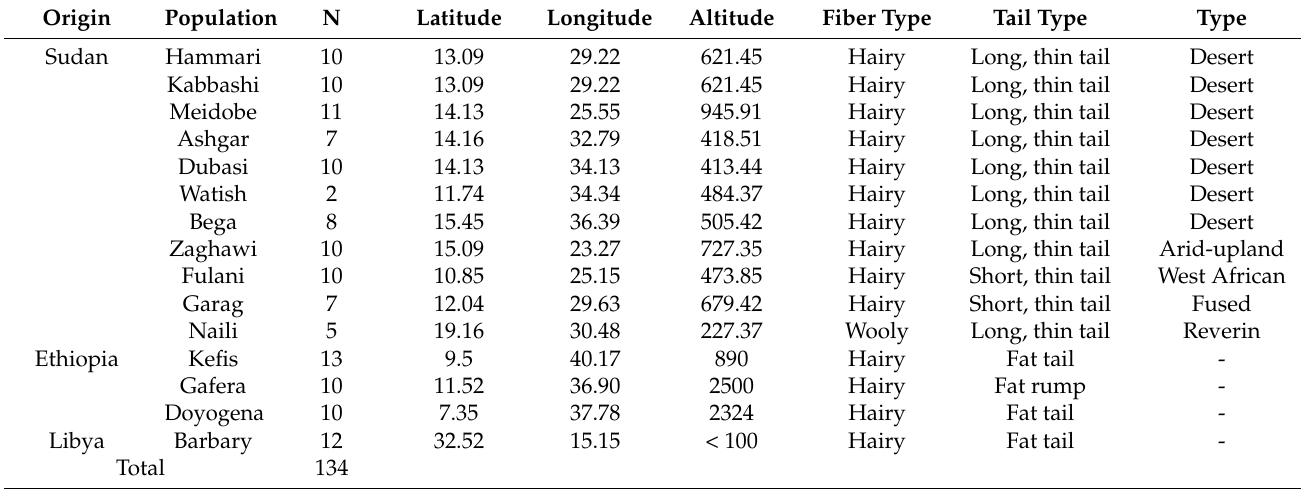
Table 1. Summary of the studied sheep populations and their geographical distribution.